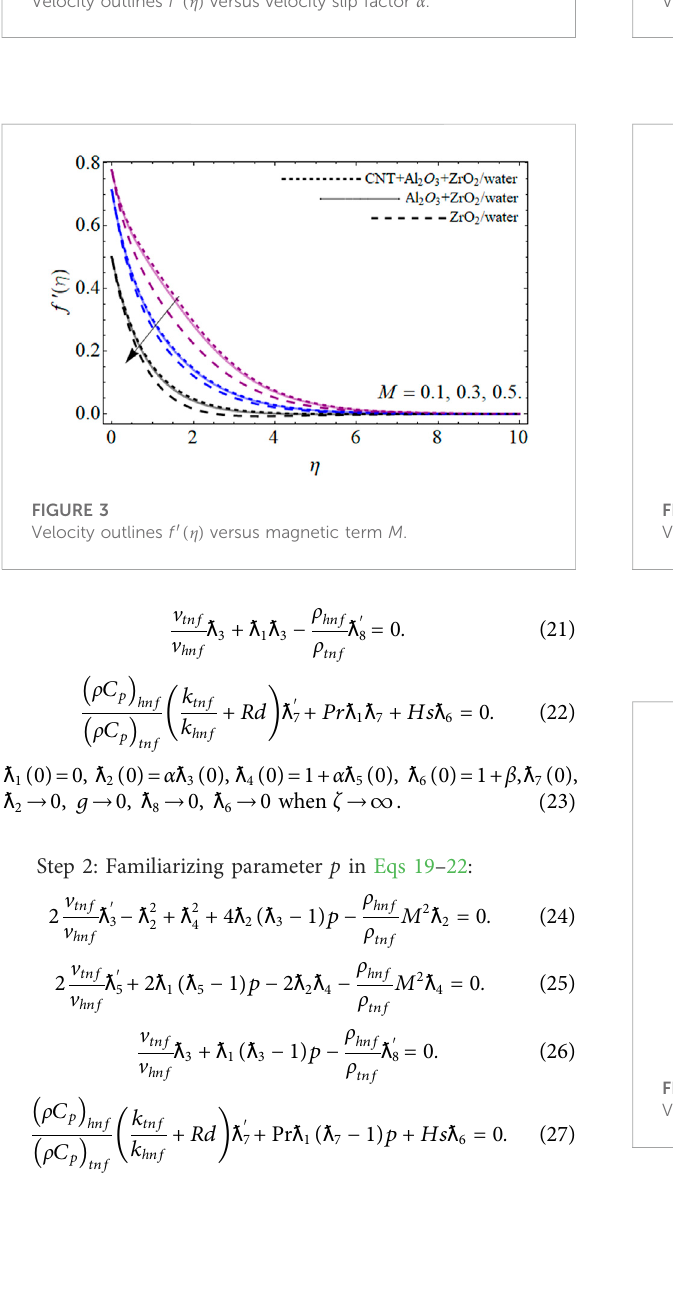
FIGURE 4 Velocity outlines f ′ ( η ) versus ternary nanoparticles ϕ .